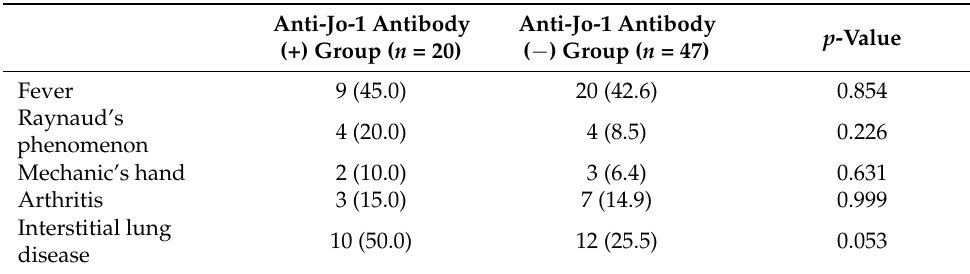
Table 2. Comparison of clinical features of anti-synthetase syndrome according to anti-Jo-1 antibody positivity and